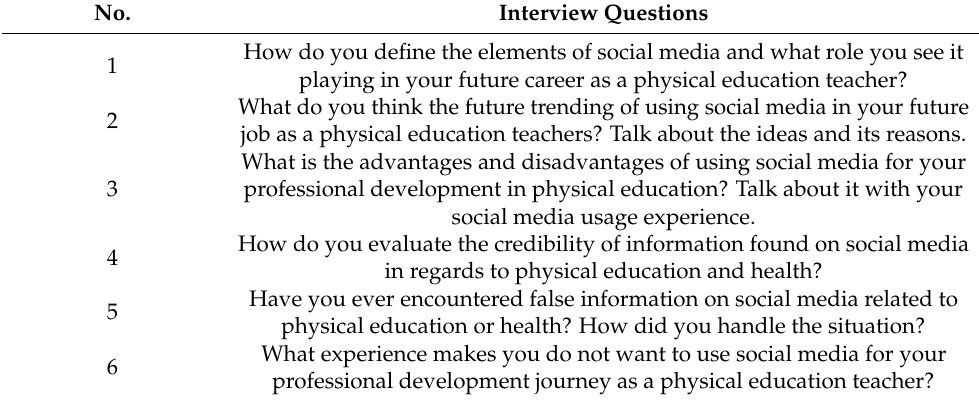
Table 2. Interview